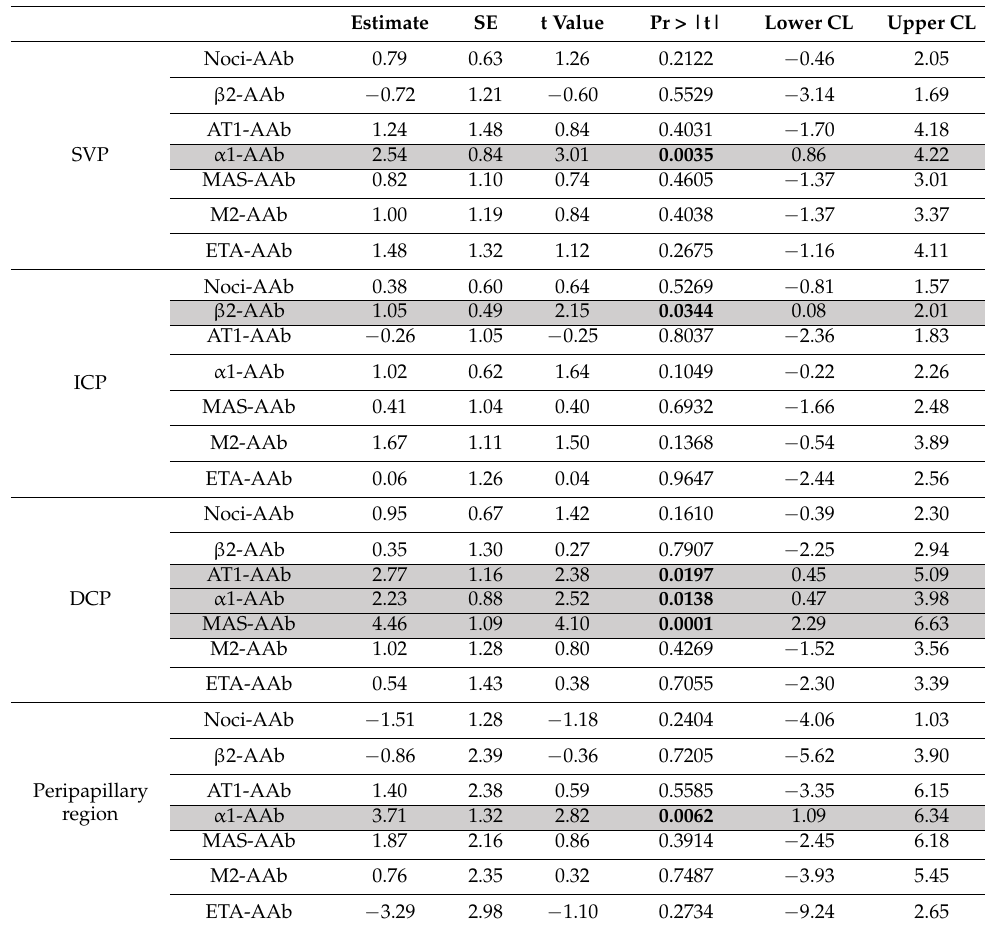
Table 3. Differences of the LS means (seronegativity versus seropositivity) from the mixed models for overall macula and peripapillary region vessel density considering the GPCR-AAb status. The differences were calculated between the LS mean estimations of seronegativity and seropositivity of GPCR-AAb; moreover, we calculated the lower and upper confidence limits (CLs); SVP—superficial vascular plexus; ICP—intermediate capillary plexus; DCP—deep capillary plexus; SE—standard error; the estimates are represented as the differences between the seronegativity estimate and the seropositivity